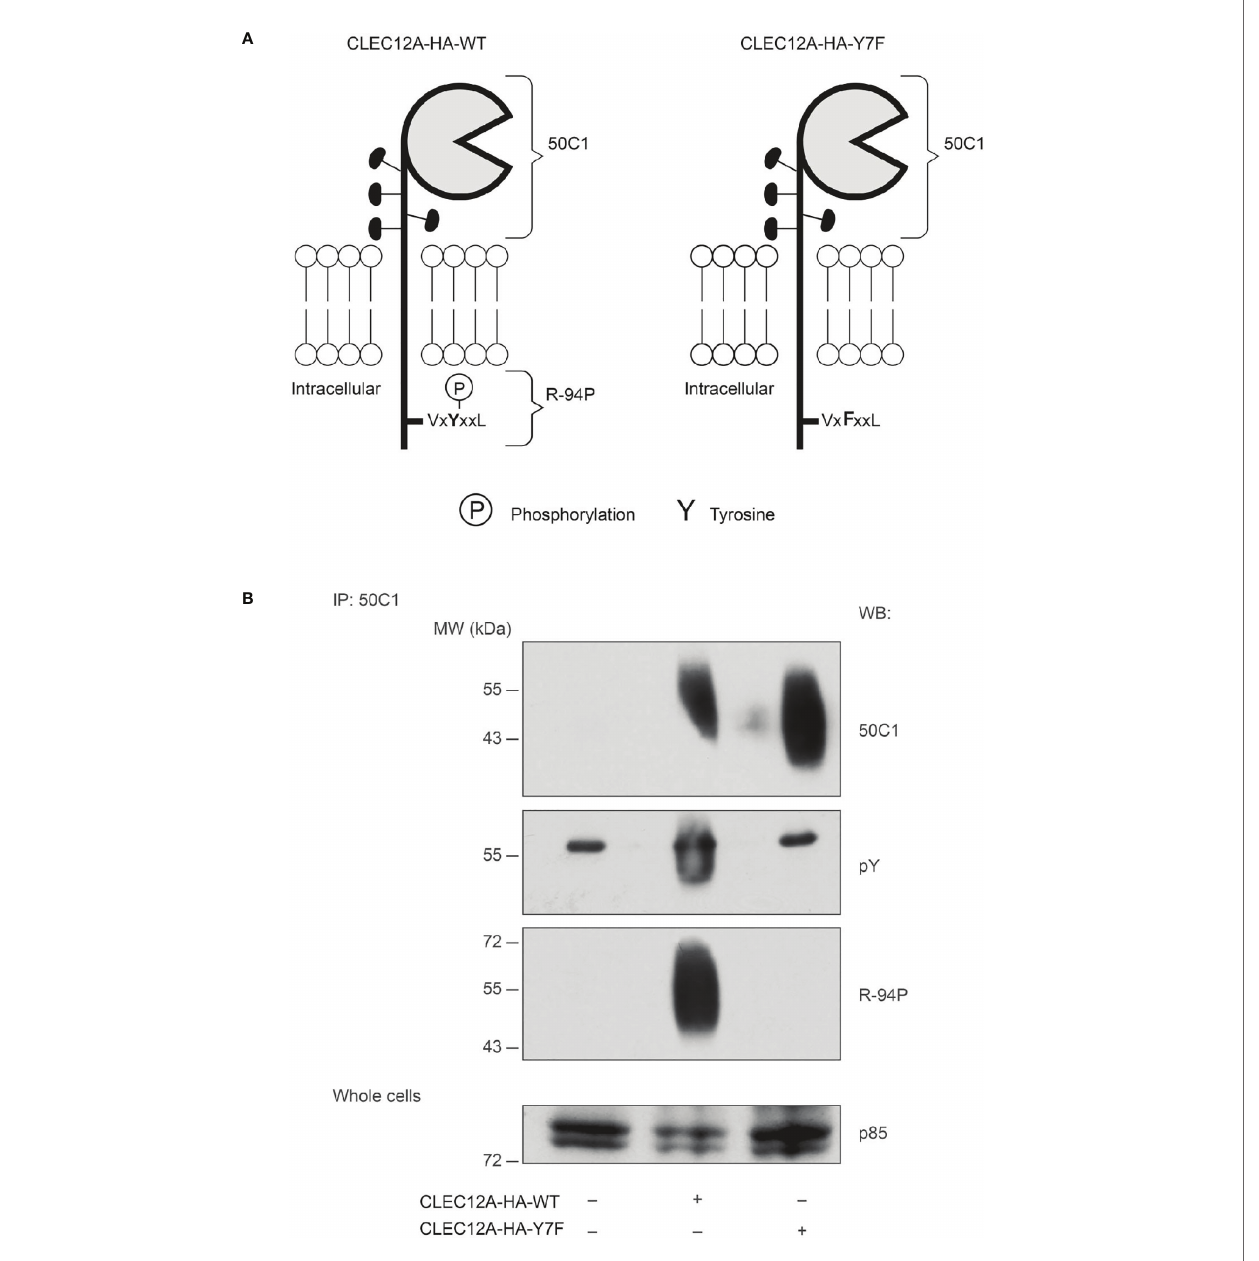
FIGURE 3 | Antibody-induced cross-linking of CLEC12A induces the phosphorylation of its ITIM in HEK-293T cells. (A) A schematic diagram of the wild-type (CLEC12A-HA-wt) and mutant (CLEC12A-HA-Y7F) constructs. Regions of the receptor recognized by 50C1 and the anti-CLEC12A ITIM phopsho-antibody, R-94P, are indicated by brackets. (B) HEK-293T cells transiently transfected with CLEC12A-HA-wt or CLEC12A- HA-Y7F were treated with pervanadate prior to immunoprecipitating with 50C1 and immunoblotting with 50C1, R-94P, an anti-phospho-tyrosine ( pY ) antibody or an anti-p85 subunit of PI3K ( p85 ) antibody ( loading control ). Data are representative of 3 independent